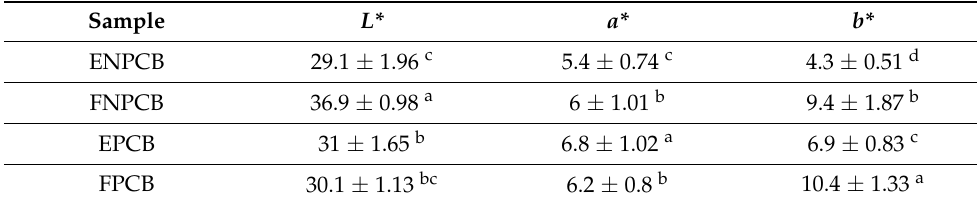
Table 7. Color parameters of gluten-free cereal